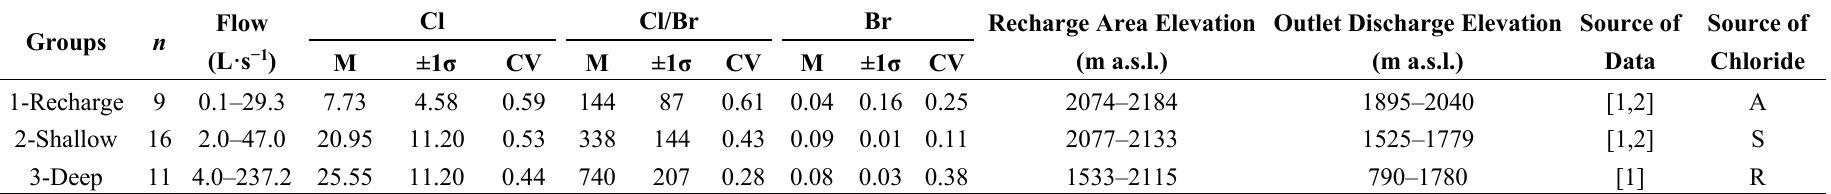
Table 2. Chloride and bromide content, and Cl/Br ratio in groundwater in the Las Cañadas Caldera area. Sampling points were clustered into 3 groups attending to groundwater flow type and the origin of chloride.